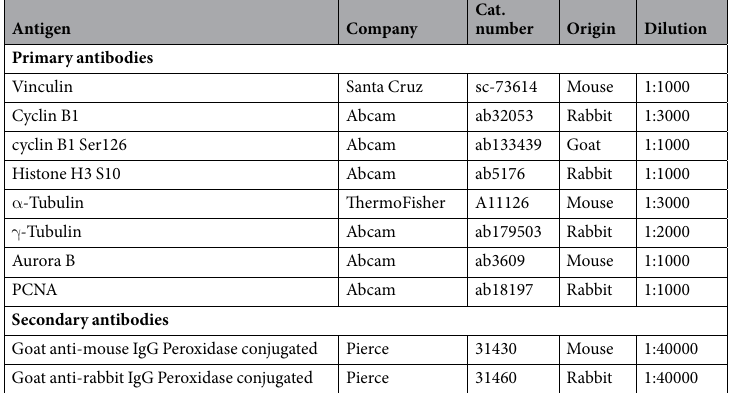
Table 1. Primary and secondary antibodies used for immunoblotting.